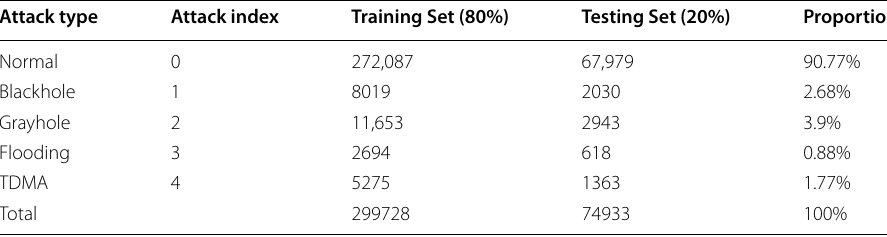
Table 5 Distribution of WSN-DS